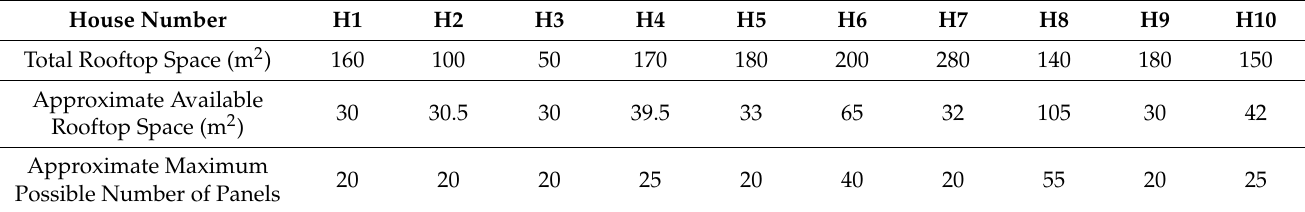
Table 2. Available roof space in comparison with photovoltaic (PV) system sizing.